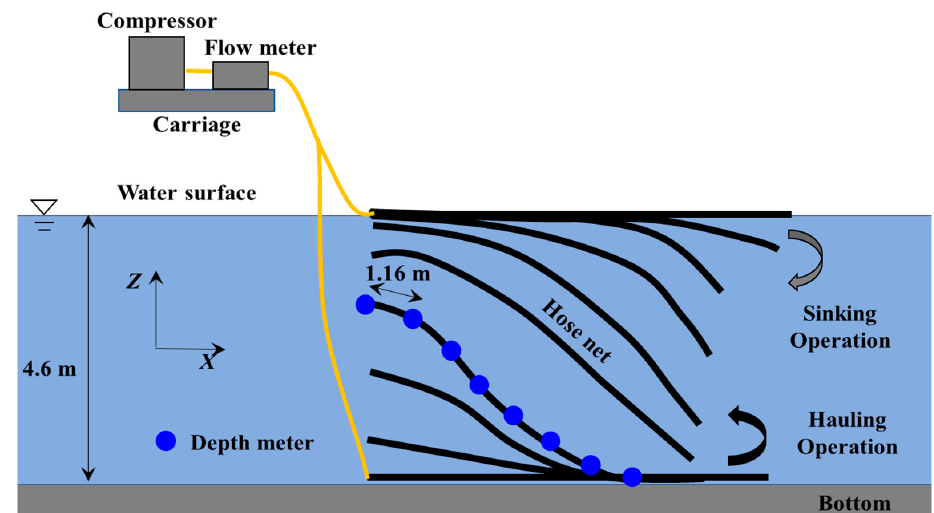
Figure 4. Side-view schematic of the experimental setup.